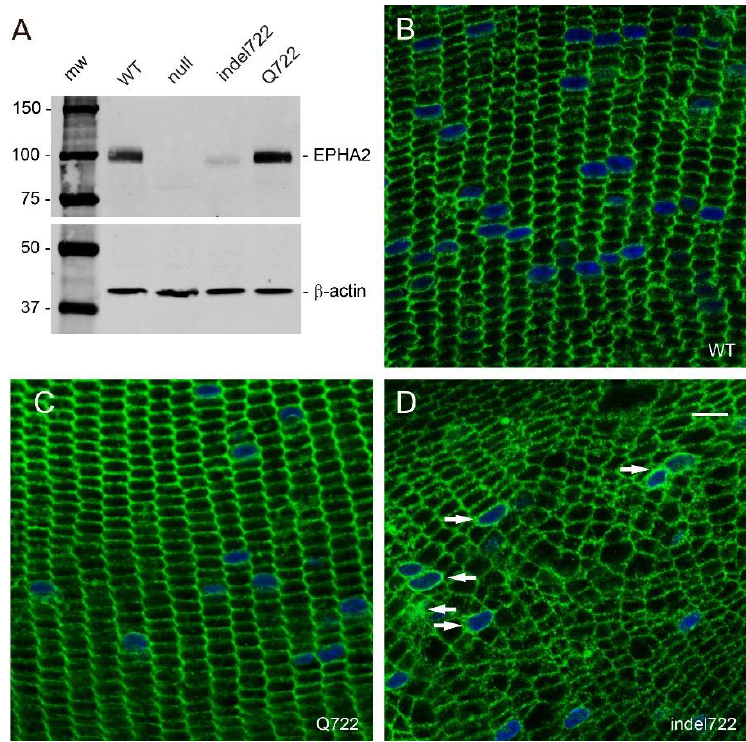
Figure 5. Expression and distribution of EPHA2 mutants in the lens. ( A ) Immunoblot analysis of Epha2 -mutant lenses. ( B – D ). Immuno-localization of EPHA2 in wild type ( B ), Epha2 -Q722 ( C ), and Epha2 -indel722 ( D ) mutant lenses (P21). Arrows in panel D indicate intracellular and/or perinuclear localization of EPHA2. Scale bar, 10 µm.